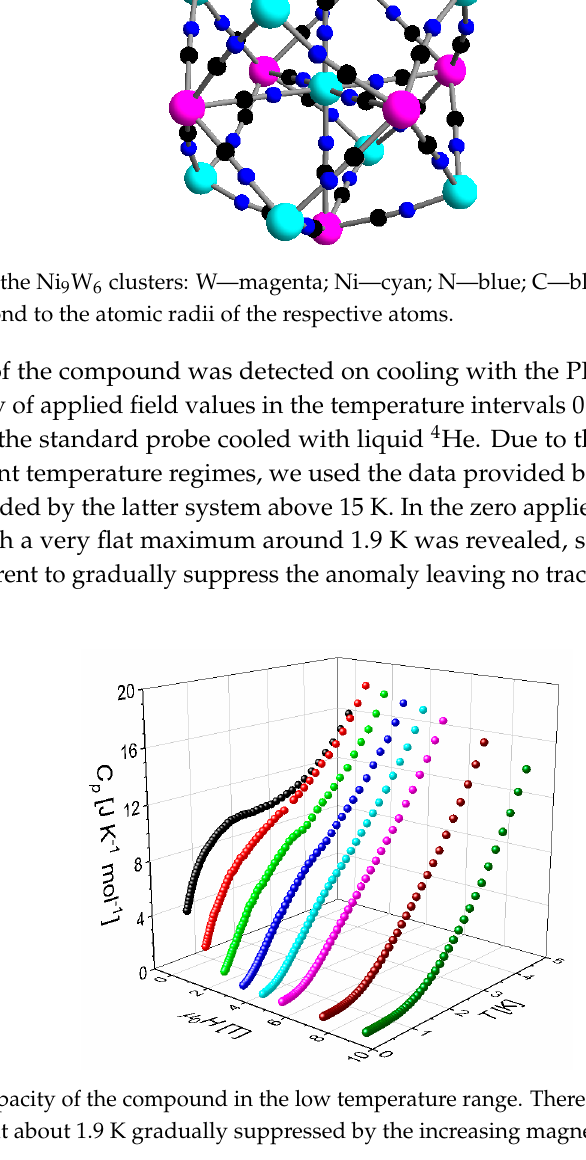
Figure 2. Heat capacity of the compound in the low temperature range. There is a broad anomaly with a flat maximum at about 1.9 K gradually suppressed by the increasing magnetic field.